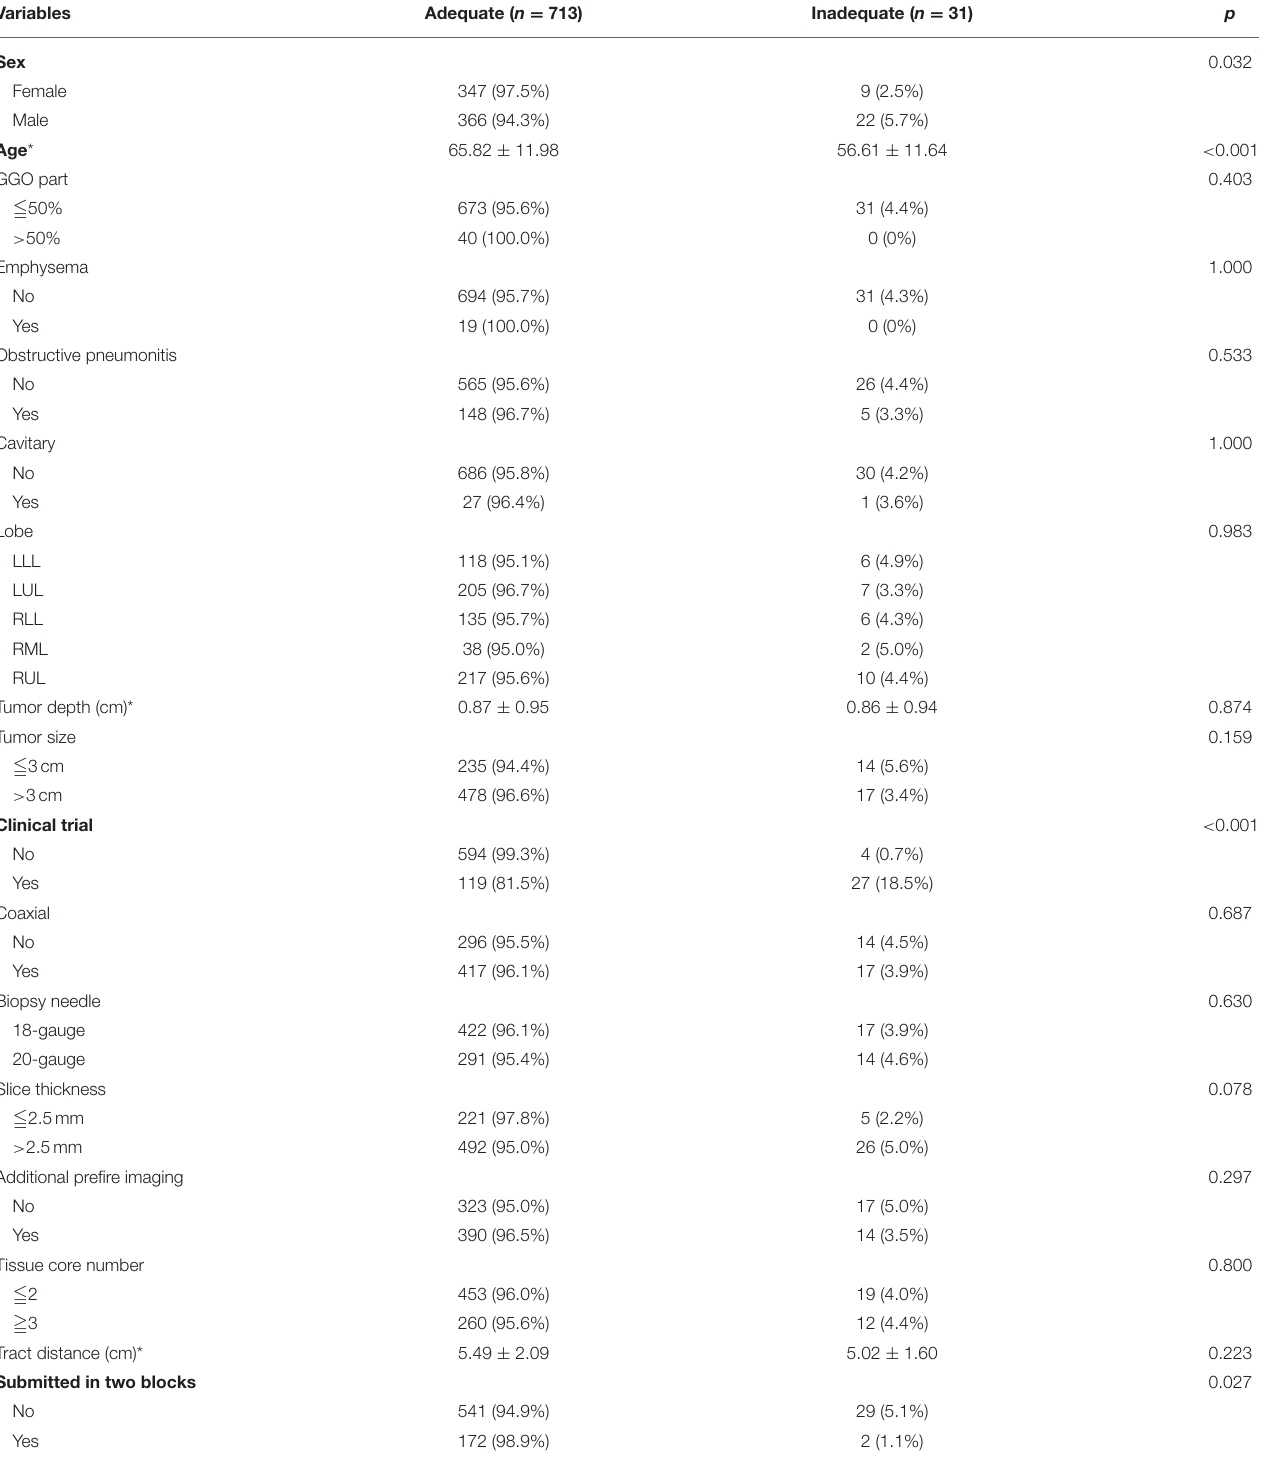
TABLE 4 | Predictors for tissue adequacy of CT-guided